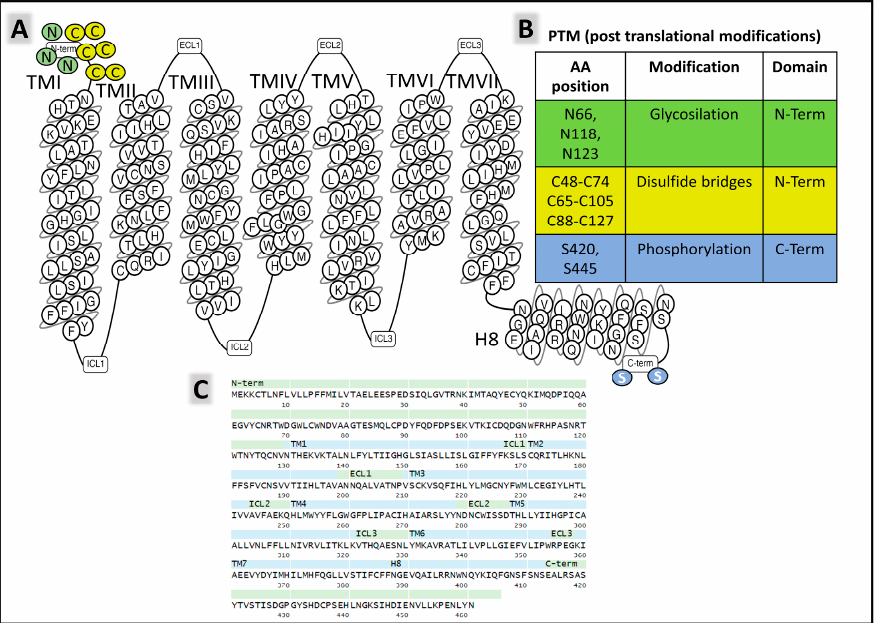
Figure 9. ( A ) is a snake plot [47] of the general architecture of CLR (calcitonin receptor-like receptor), indicating transmembrane segments and intra- (ICL) and extracellular (ECL) loops. ( B ) displays amino acids undergoing post-translational modifications [25]. ( C ) shows the primary structure of the receptor and the sequences forming different protein domains [47], TM (transmembrane), ECL (extracellular loops), ICL (intracellular loops), and H8 (helix 8). RAMP1 is a chaperone protein with a single transmembrane domain that alloster- ically modulates CLR function [123]. It sits within transmembrane (TM) helices TM3, TM4, and TM5 of CLR (Figure 10). The signaling efficiency of the receptor complex CLR-RAMP activated with different affinities by endogenous ligands CGRP, AM, AMY, and CT improves with a third proteinaceous component directly interacting with CLR, the RCP (receptor component protein) [124–126].